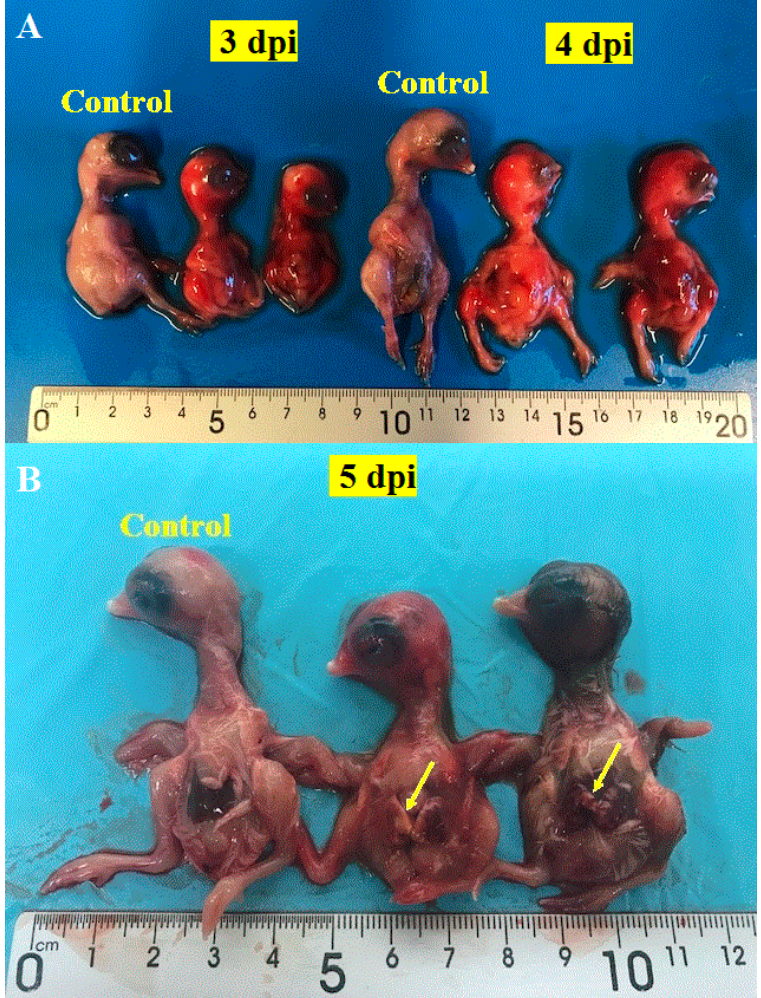
Figure 2. Chicken embryos after infection with USU-BE-Seraing/2017 strain using the allantoic route. ( A ) The infected chicken embryos showed cutaneous hemorrhage compared with the non-infected controls. ( B ) Unlike the non-infected embryo, the infected embryos (in the middle and on the right of the picture) died and showed cutaneous hemorrhage and pallor in the